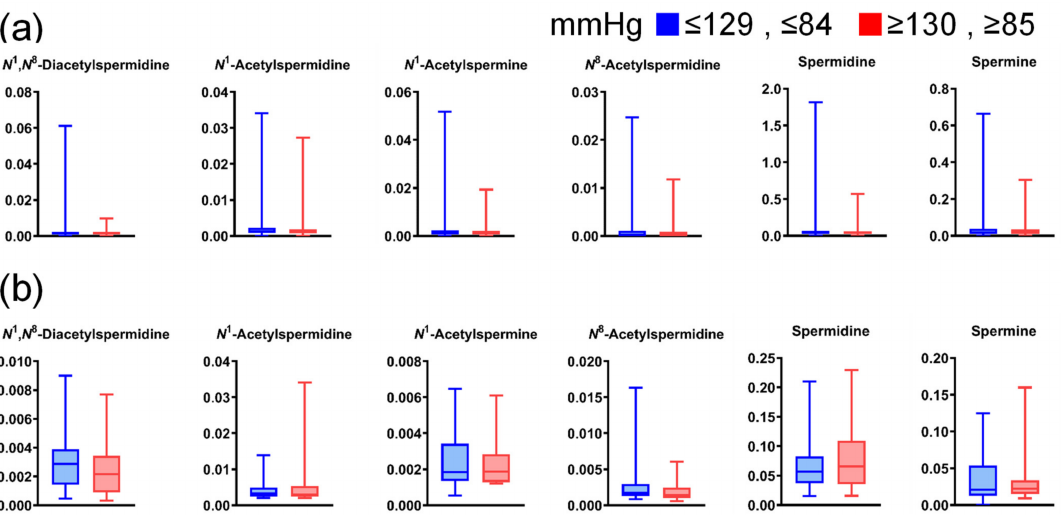
Figure A5. Differences in salivary polyamine concentrations between participants with high and low blood pressure. ( a ) Data for healthy individuals (low, n = 744; high, n = 180) and ( b ) patients with pancreatic diseases (low, n = 45; high, n = 22). Horizontal lines of box plots present 0, 25, 50, 75, and 100% of data. All comparisons show p > 0.05, using the Mann–Whitney U test.